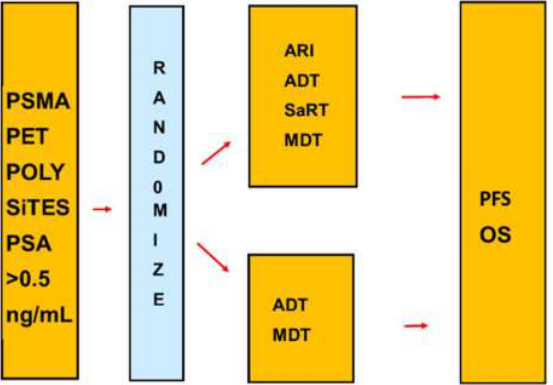
Figure 6. Design for a phase III trial of patients with PSA-only recurrence and high risk according to the new risk model. The trial compares an aggressive multimodality salvage treatment with salvage treatment with established treatments. Abbreviations: ARI second generation androgen receptor inhibitor, MDT metastasis directed therapy, OS overall survival, PFS progression-free survival, SaRT Salvage radiation